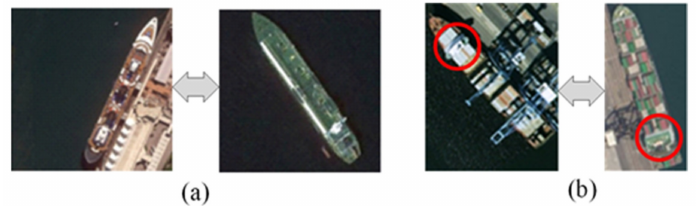
Figure 1. ( a ) Inter-class similarity, take ocean liner and ferry boat for example. ( b ) Intra-class differences, taking different container ships as an example, the position of the bridge is marked with red